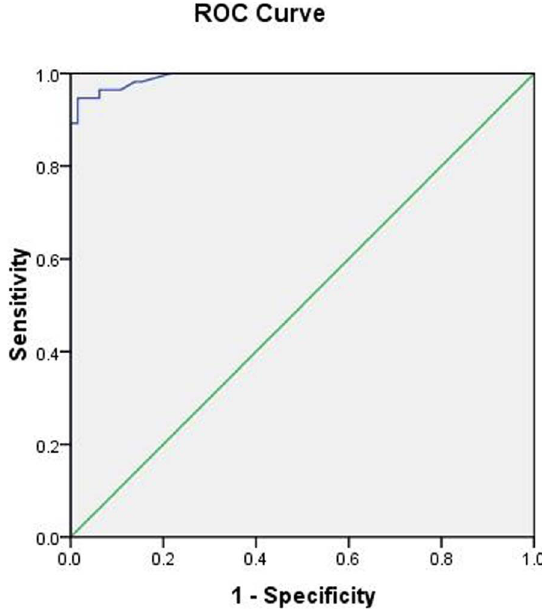
Figure 3. Receiver operating characteristics curves for T2* value in metastatic and benign axillary lymph nodes discrim- ination.